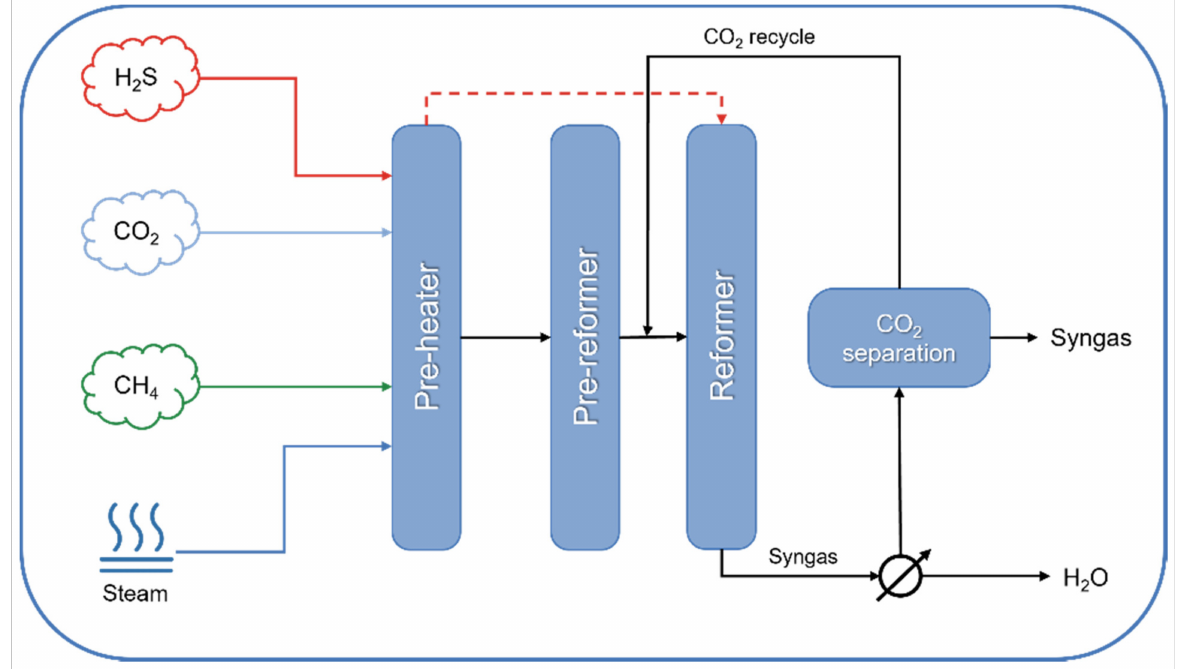
Figure 8. Simplified block diagram of the SPARG™ process for syngas production